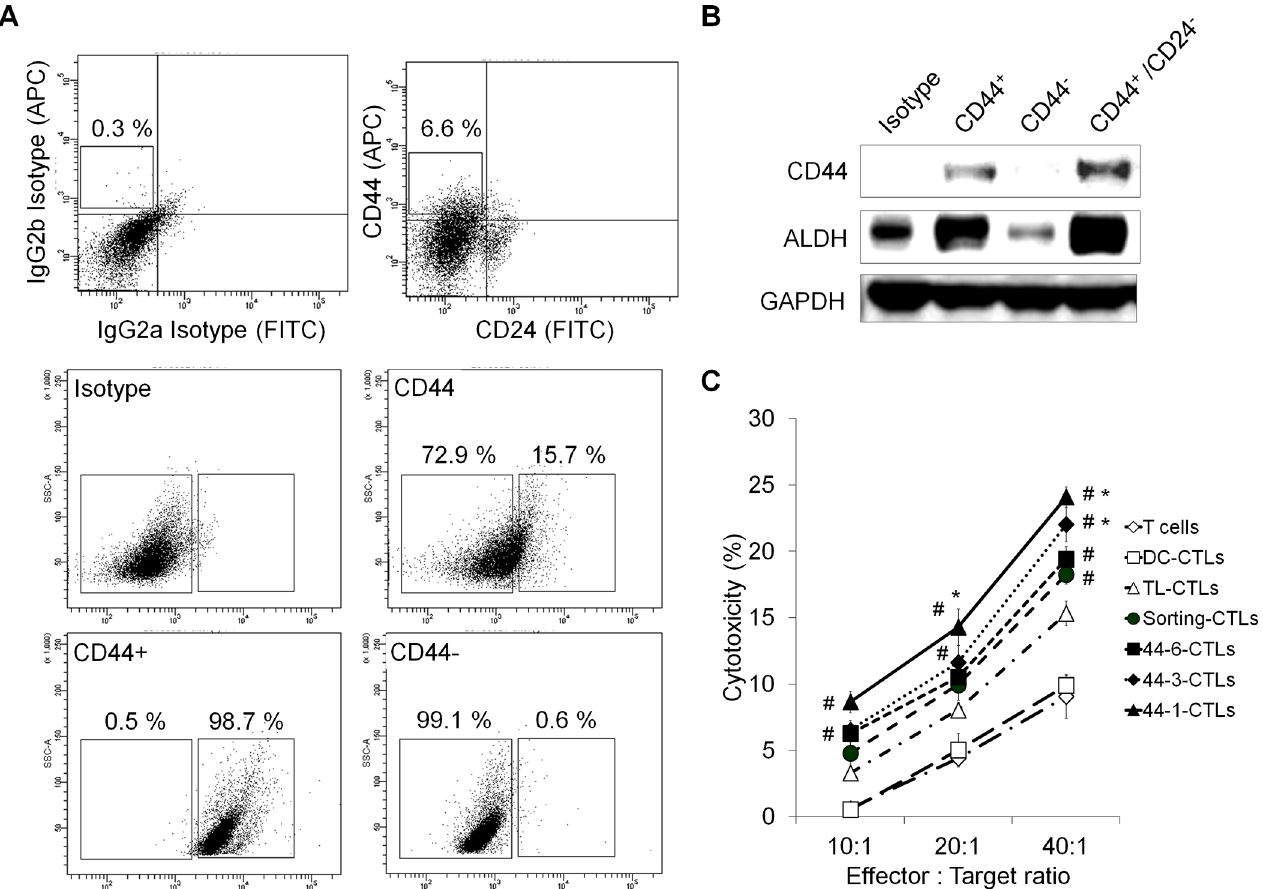
Fig 1. The specific lytic activity of MCF-7 cancer stem-like cell antigens. (A) Identification of populations of MCF-7 cells by flow cytometry analysisof CD44 and CD24 expression. (B) Western blot showingCD44and ALDH protein expressionin CD44 + , CD44 - and CD44 + CD24 - MCF7- cells. (C) Targeted killingof CD44 + MCF-7 cells by tumor-associated antigen-pulsed, DC-inducedCTLs. The data are expressedas the mean ± SD, and significantdifferences betweenthe treated groupswere detected using ANOVA followedby the Dunnett’s test. # p < 0.05comparedwith the DC-CTLs. * p < 0.05comparedwith the